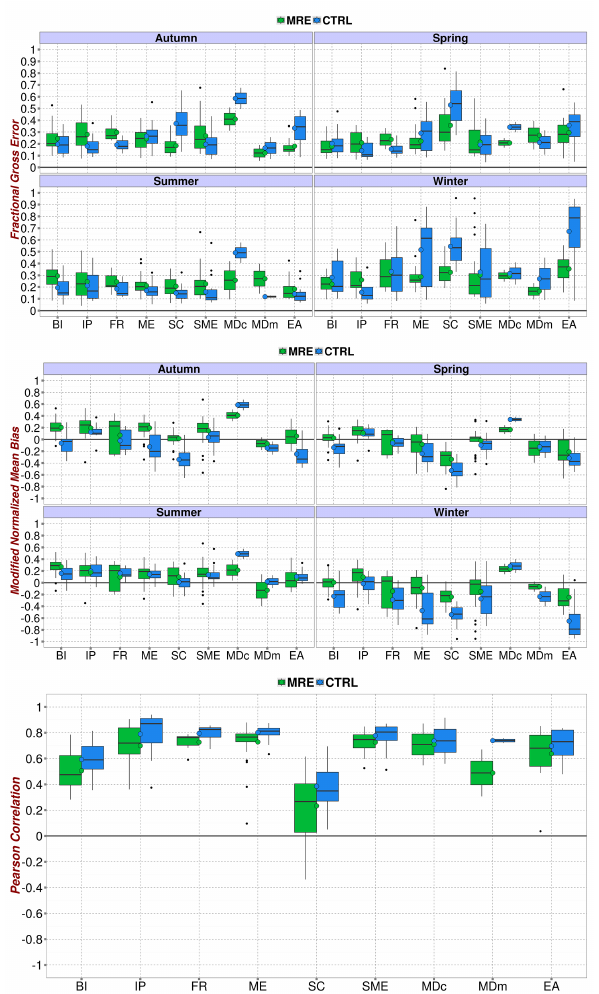
Figure 3. Average 2003–2010 seasonal FGE (top), MNMB (mid- dle) and annual R (bottom) of near-surface ozone for the different European subregions of the MACC reanalysis (green) and the con- trol run (blue).